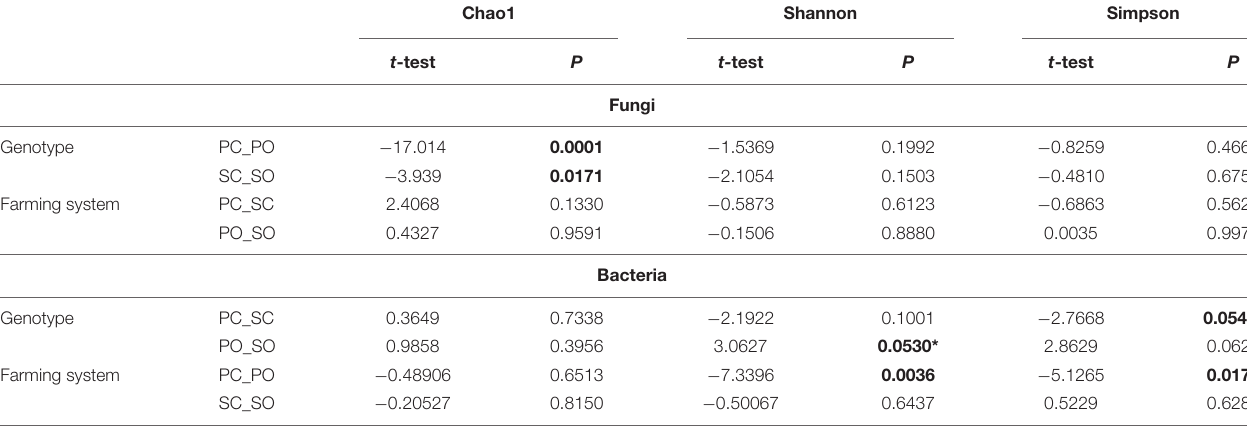
TABLE 1 | Experimental factors predicting α diversity of the rhizosphere-associated fungal and bacterial communities in maize. Chao1